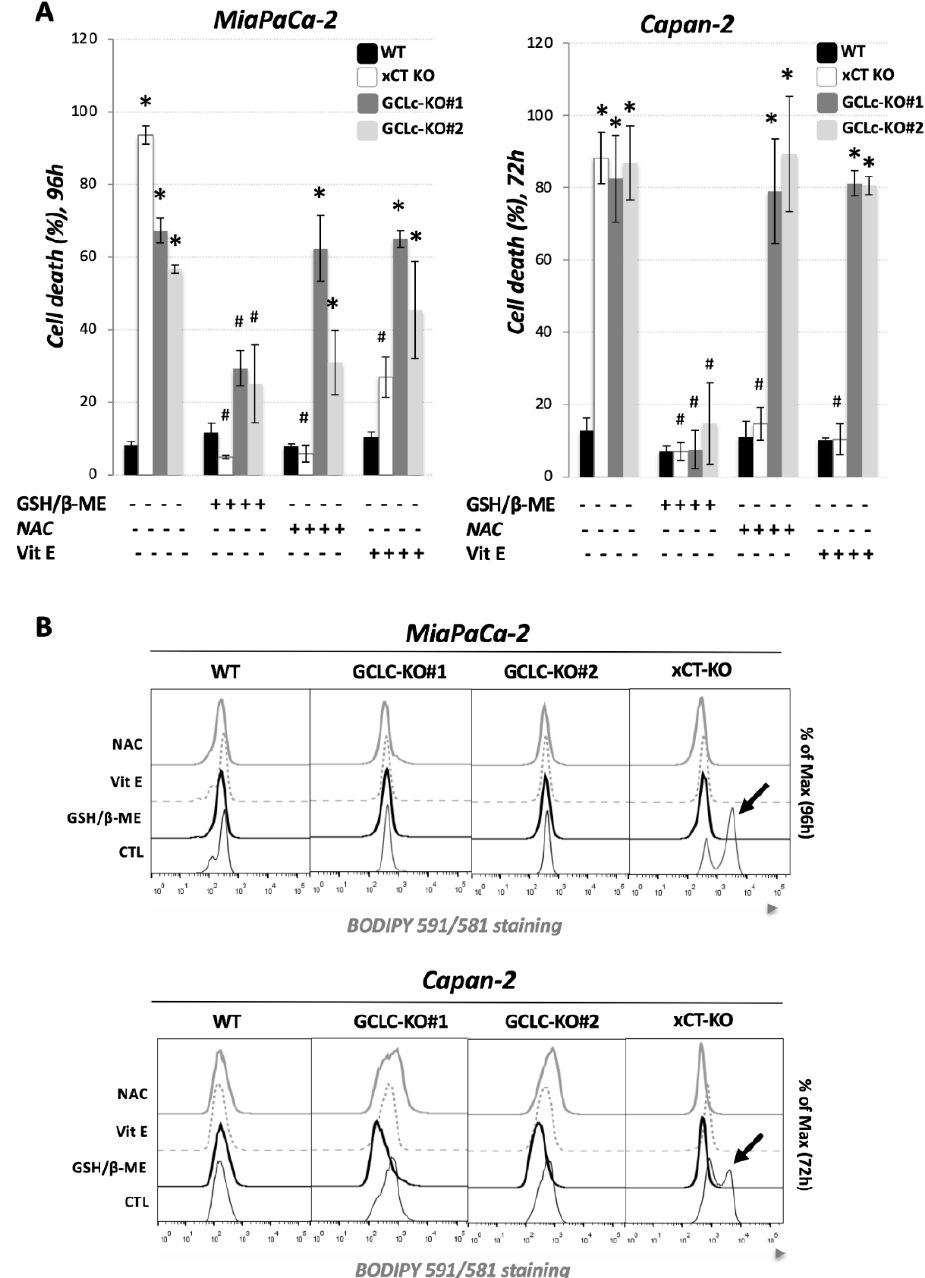
Figure 2. Genetic deletion of GCLc does not induce ferroptosis in PDAC cell lines. ( A ). Cell viability was measured using PI staining method (see Material & Methods). Cells were seeded in media supplemented or not with 3 mM glutathione (GSH) + 100 µ M β -mercaptoethanol ( β -ME), 1 mM N-acetylcysteine (NAC) or 10 µ M vitamin E (Vit E), and cell viability was analyzed after 72 h (for Capan-2), i.e., 96 h (for MiaPaCa-2). The results are presented as mean ± SEM, n = 3. * p < 0.05, comparison with WT cells in control conditions; # p < 0.05, comparison with corresponding cell line in control conditions. ( B ). Lipid hydroperoxide content was measured in WT, GCLc-KO and xCT-KO cells 72 h (for Capan-2), i.e., 96 h (for MiaPaCa-2) upon seeding in media supplemented or not with 3 mM glutathione (GSH) + 100 µ M β -mercaptoethanol ( β -ME), 1 mM N-acetylcysteine (NAC) or 10 µ M vitamin E (Vit E). xCT KO cells were used as ferroptotic positive control (black arrow) based on our previously published data (see the text). Presented histograms are representative of three independent experiments.